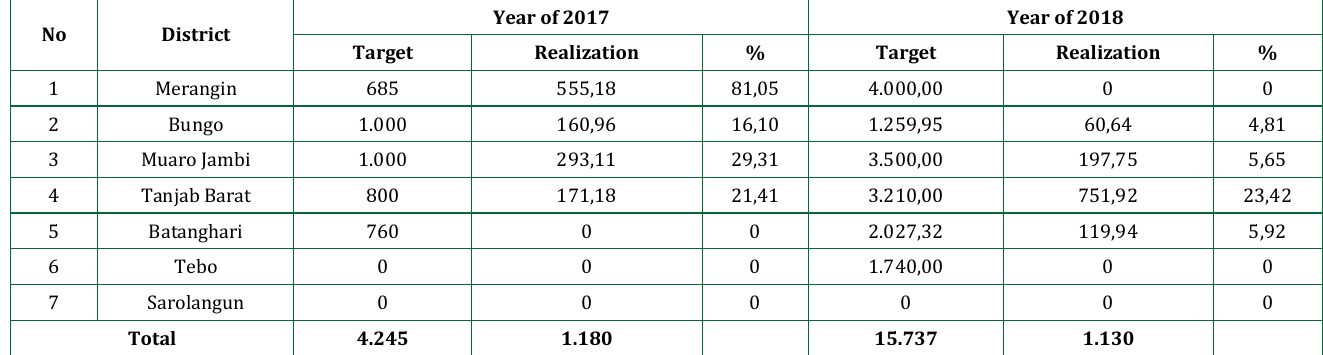
Table 4: Target and Realization of Replanting Land Acreage of Smallholders Oil Palm in Jambi Province, Year of 2017 – 2018 No